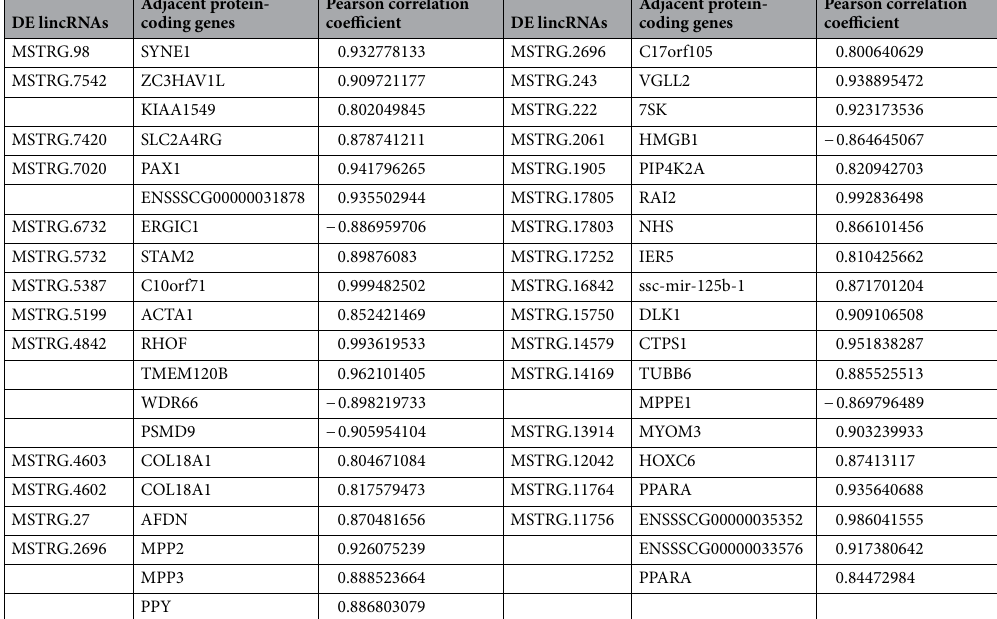
Table 3. The correlation between DE lincRNA genes and their adjacent protein-coding